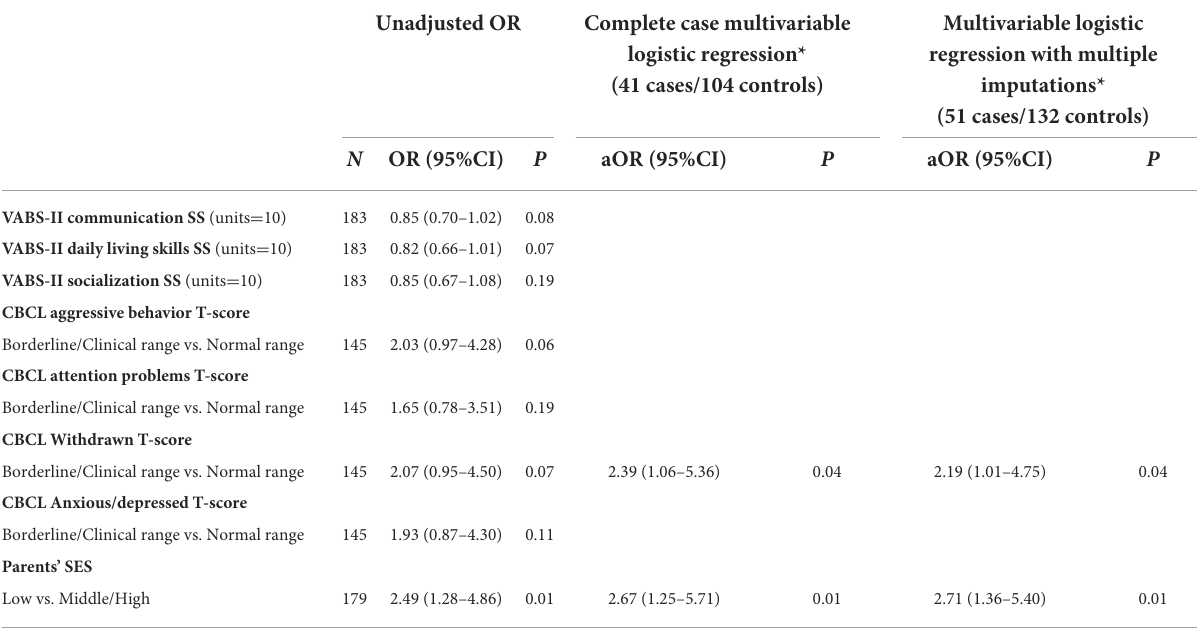
TABLE 2 Risk factors for excessive screen time in children bellow 12 years